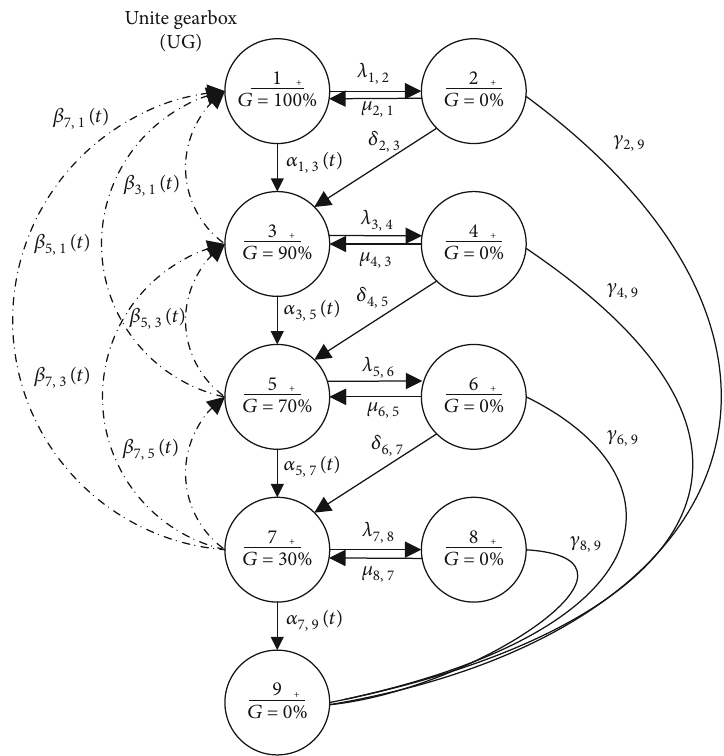
Figure 4: State-transition diagram of unite gearbox.